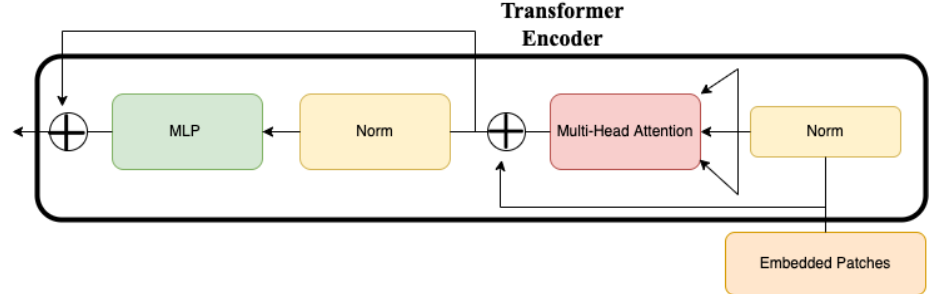
Figure 3. Overview of the transformer